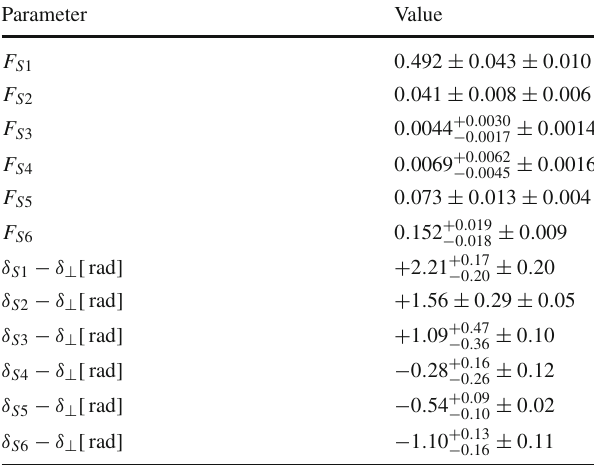
Table 8 Values of the S-wave parameters in each m ( K + K − ) bin. The first uncertainty is statistical and the second systematic